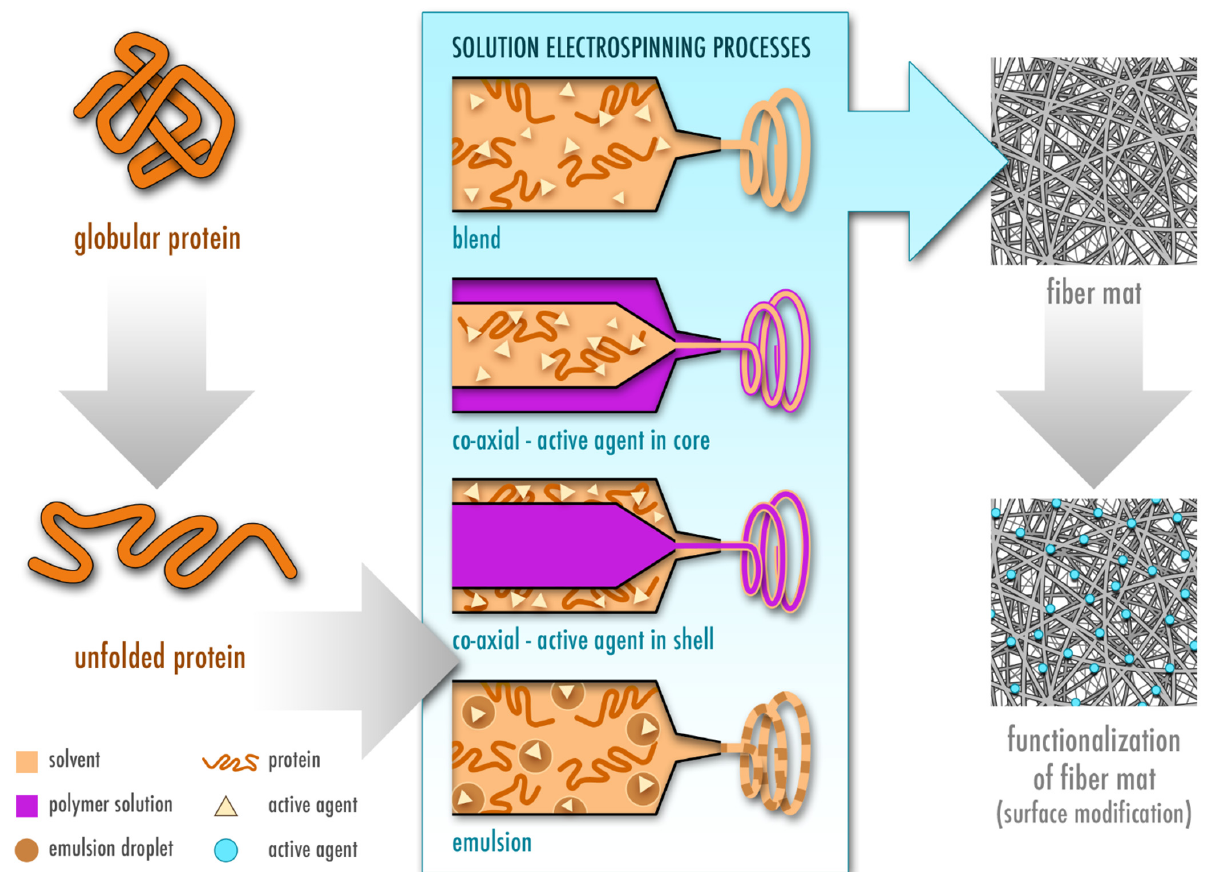
Figure 3. Fabrication of protein-based electrospun fiber mats by different types of solution electrospinning, namely blend, co-axial and emulsion electrospinning. The protein is first dissolved in a volatile solvent and starts unfolding, which is a prerequisite for successful electrospinning of proteins. In blend electrospinning, the active agent is directly added to the polymeric protein solution. In co-axial electrospinning, the active agent is either dissolved in the shell or the core solution. In addition to the protein solution, a second natural or synthetic polymer is used in co-axial electrospinning. In emulsion electrospinning, the drug is dissolved in the emulsion droplets (inner phase). In addition, the fibrous mat can be functionalized by adding the active agent after